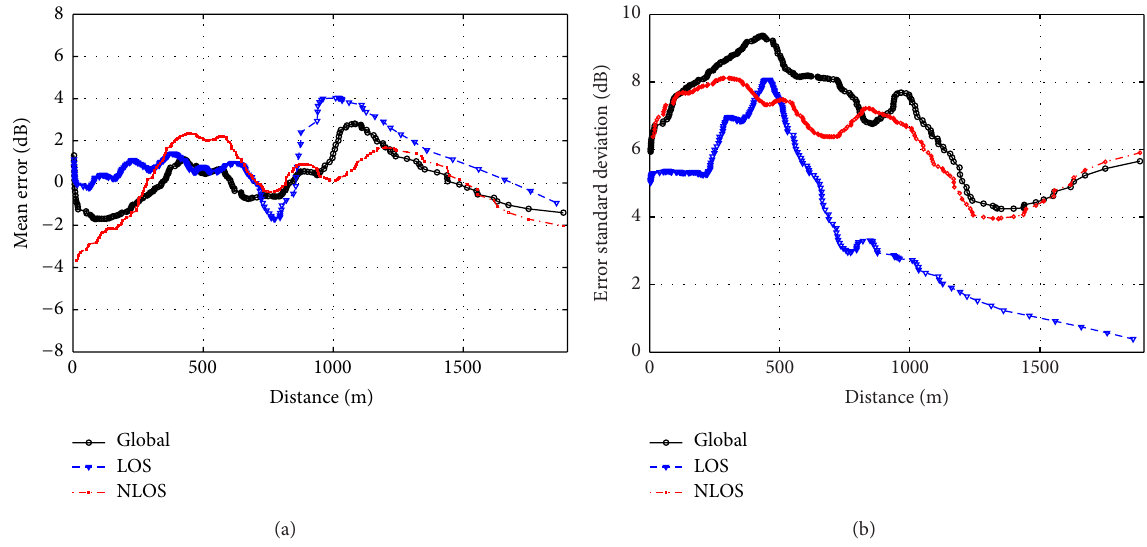
Figure 3: Mean error (a) and standard deviation of the error (b) for all sites and for LOS and NLOS Rx